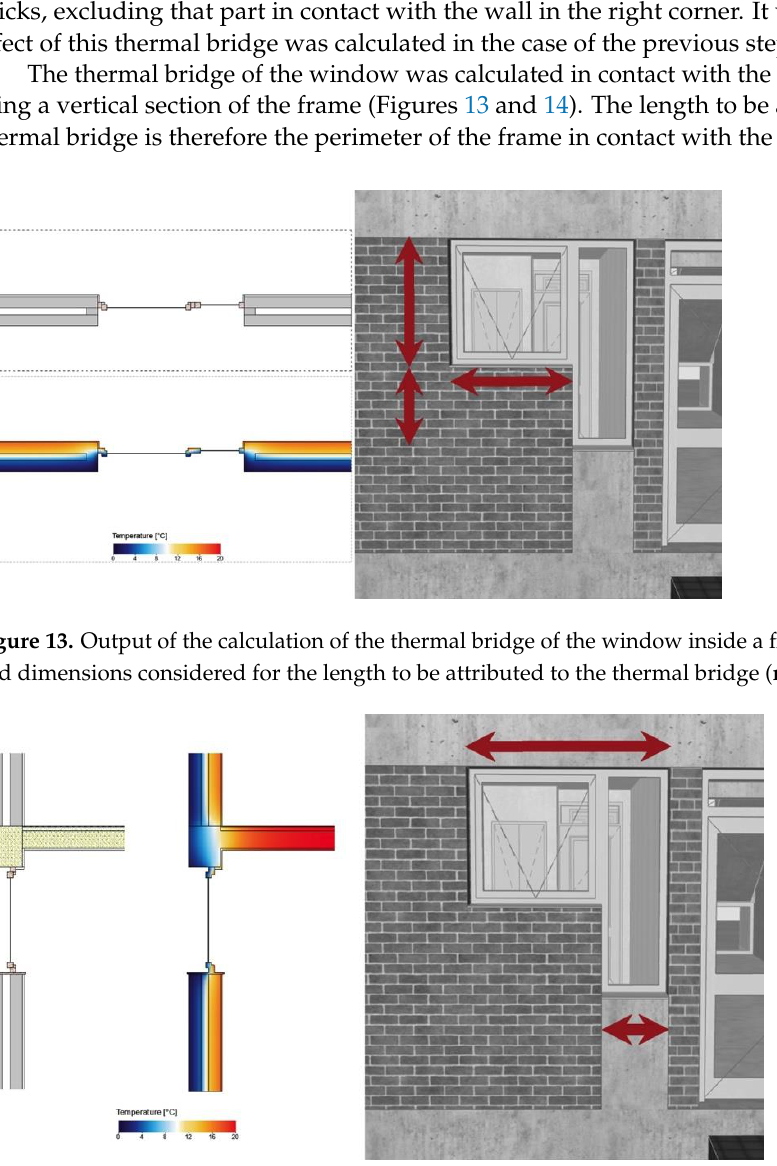
Figure 14. Output of the calculation of the thermal bridge of the window in contact with the concrete ( left ) and dimensions considered for the length to be attributed to the thermal bridge ( right ).